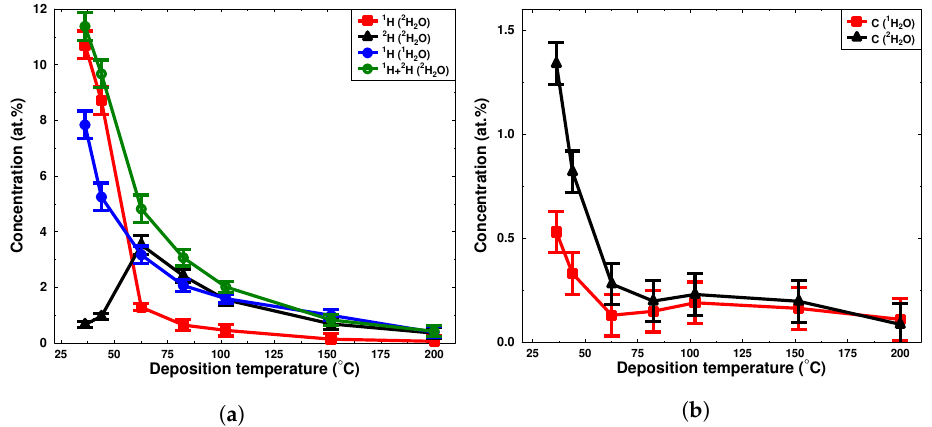
Figure 5. ( a ) Hydrogen isotope and ( b ) carbon concentration of the films deposited at different temperatures using 150 ms DEZ and 500 ms 1 H 2 O or 2 H 2 O pulses. Purging times after the precursor pulses were 10 and 20 s,